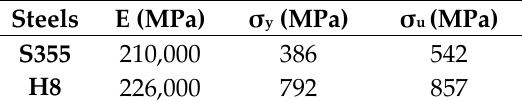
Table 1. Tensile properties of the steels.